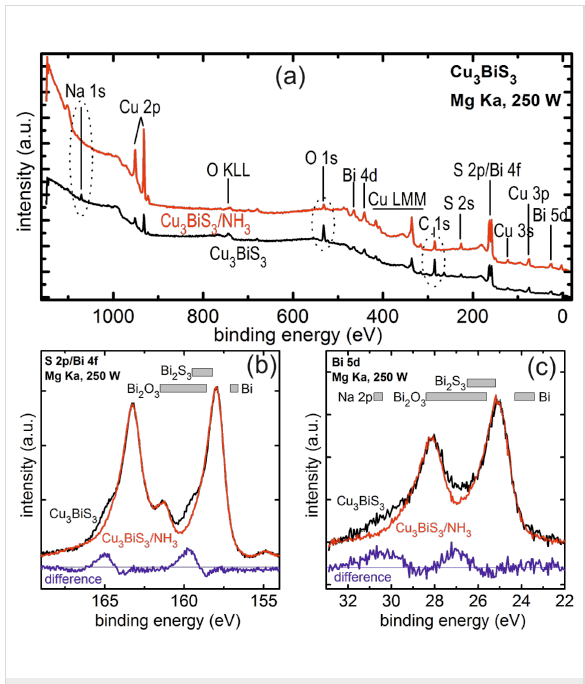
Figure 1: XPS measurements on Cu 3 BiS 3 and Cu 3 BiS 3 etched in NH 3 . (a) Overview spectrum showing that Na, oxides, and C contami- nation are effectively reduced by the NH 3 etch. (b) Detailed spectrum of the S 2p and Bi 4f peaks showing the presence of Bi 2 O 3 in the as-prepared Cu 3 BiS 3 layer and its removal by the NH 3 etch. (c) Detailed spectrum of the Bi 5d and Na 2p peak showing the pres- ence of Bi 2 O 3 and Na and their effective removal by the NH 3 etch. The blue spectra represent the difference spectra between the as-prepared and the NH 3 -etched Cu 3 BiS 3